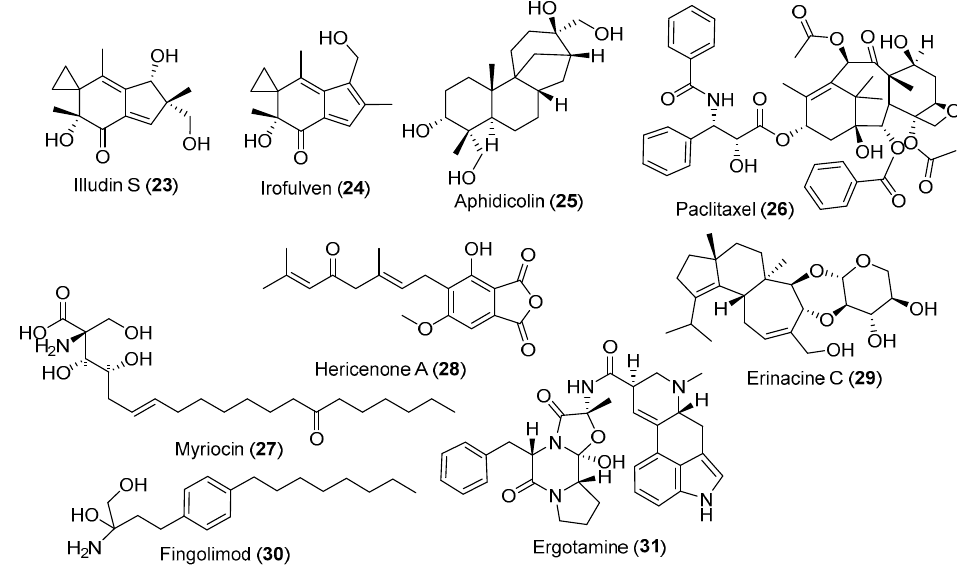
Figure 3. Selected fungal metabolites with anticancer and CNS-related effects.